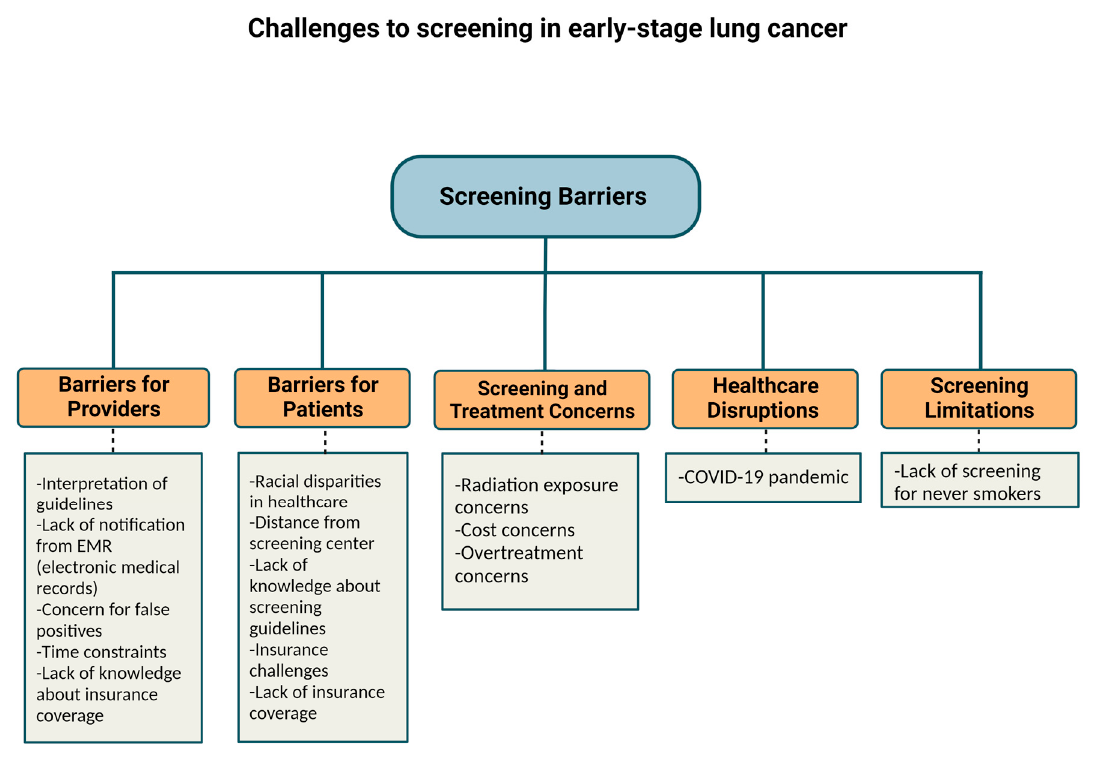
Figure 1. Low-dose computerized tomography (LDCT) screening barriers include barriers for providers, barriers for patients, screening and treatment concerns, healthcare disruptions, and screening limitations. Identifying these barriers is a critical step towards wider adoption of LDCT screening for at-risk patients. Created with BioRender.com accessed on 3 February 2023.